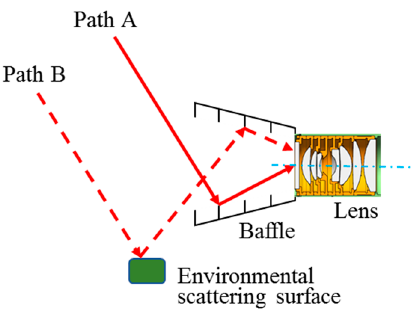
Figure 3. Stray light path.